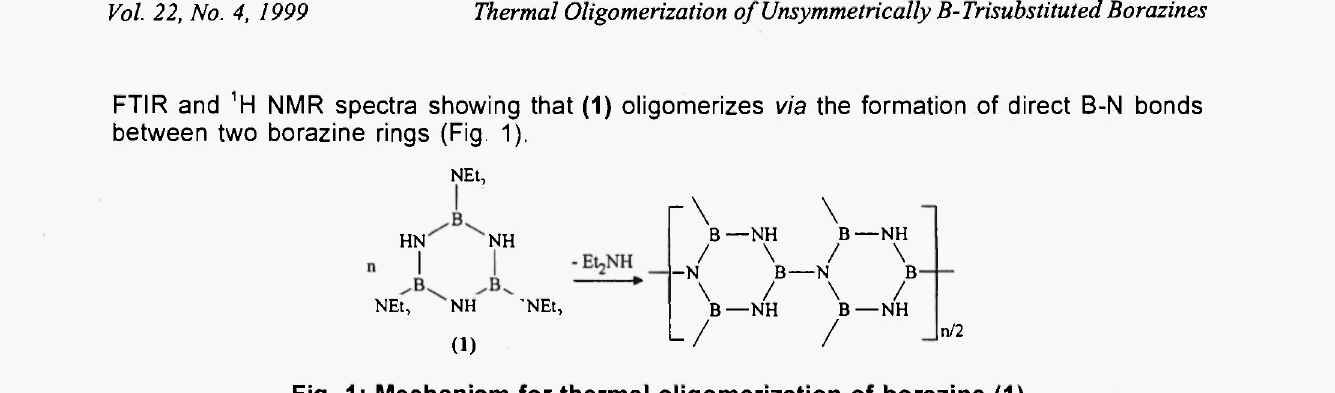
Fig. 1: Mechanism for thermal oligomerization of borazine (1)